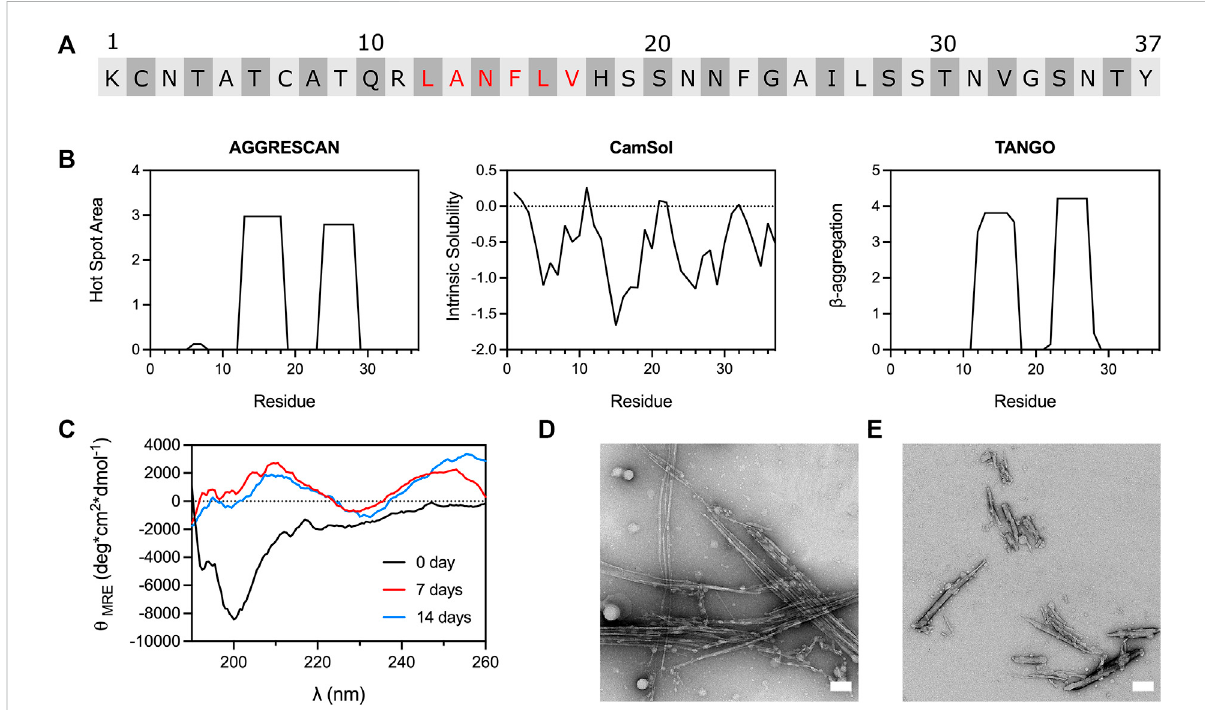
FIGURE 1 Amyloidogenicity of the 12 – 17 region of IAPP. (A) IAPP primary sequence with the residues of the 12 – 17 segment indicated in red. (B) Computational predictions performed with AGGRESCAN, CamSol and TANGO, carried out with amidated C-terminus. (C) CD spectra of IAPP 12-17 over incubation time. IAPP 12-17 peptide was solubilized at 500 μ M in 20 mM acetate buffer, pH 6.5, 3% HFIP, and incubated at 37 ° C under constant agitation. (D,E) TEM images of IAPP 12-17 peptide after 7 days incubation at 500 μ M in presence of (D) 3% HFIP and (E) 3% DMSO. Scale bars: 100